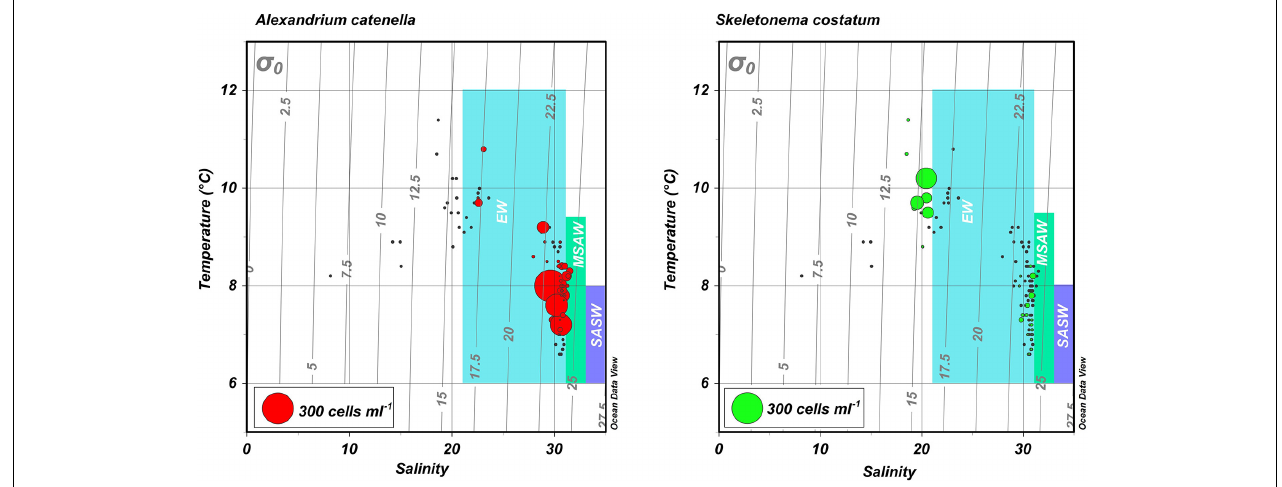
FIGURE 4 | Temperature-salinity (TS) diagrams for blooms of A. catenella in Magallanes and Tierra del Fuego regions in 1972 and 1981. Hydrographic and cell abundance data were taken from the area ( Figures 1 , 2 ) centering on Bahia Bell, Clarence Island in 1972 (Guzmán et al., 1975a; Guzmán and Lembeye, 1975; Lembeye et al., 1975) and Seno Union, 1981 (Lembeye, 1981a,b). Circles represent abundance of the dinoflagellate A. catenella (left) and the diatom S. costatum (right). Gray lines represent contours of constant density ( σ 0 ). Shaded areas are a schematic representation of the approximate salinity ranges of subantartic surface water (SASW; ∼ 33–34.6), modified subantarctic water (MSAW; ∼ 31–33), and estuarine water (EW; ∼ 21–31) according to Sievers and Silva (2008).